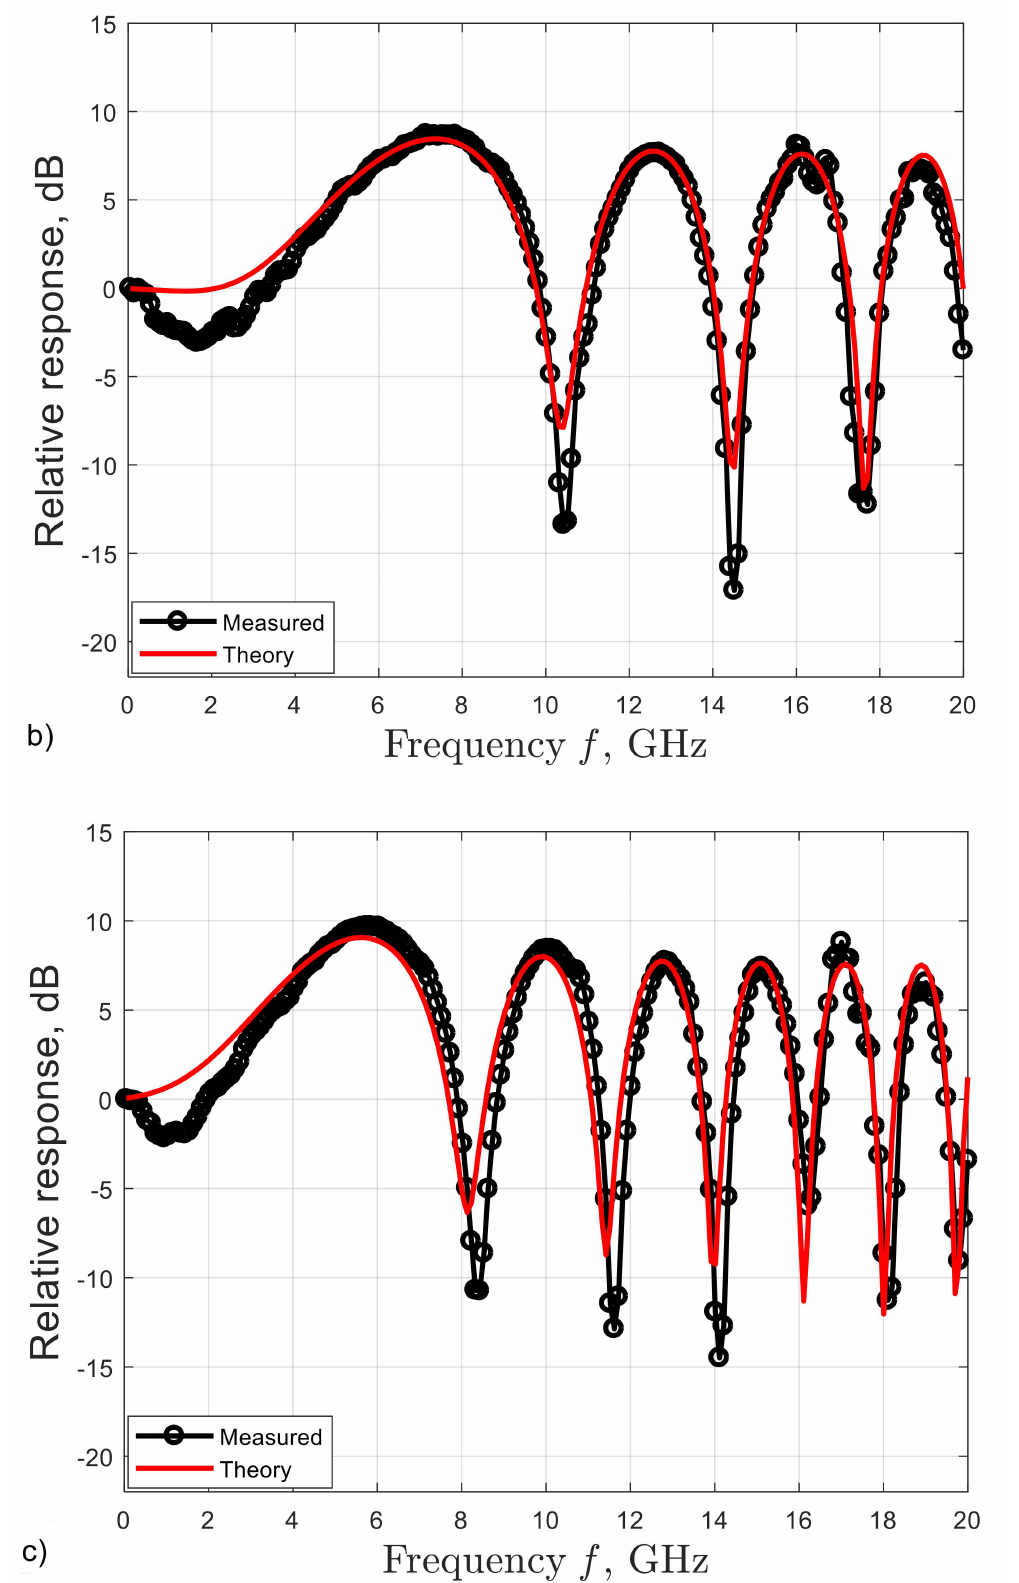
Figure 3. Frequency response of SMFs with different fiber length L in C-band (1550 nm) and with bias current of the DML i b = 60 mA. Solid line and circle: measured response. Solid line: theoretical response obtained by using Equation (1). ( a ) L = 25 km, ( b ) L = 75 km, and ( c ) L = 118